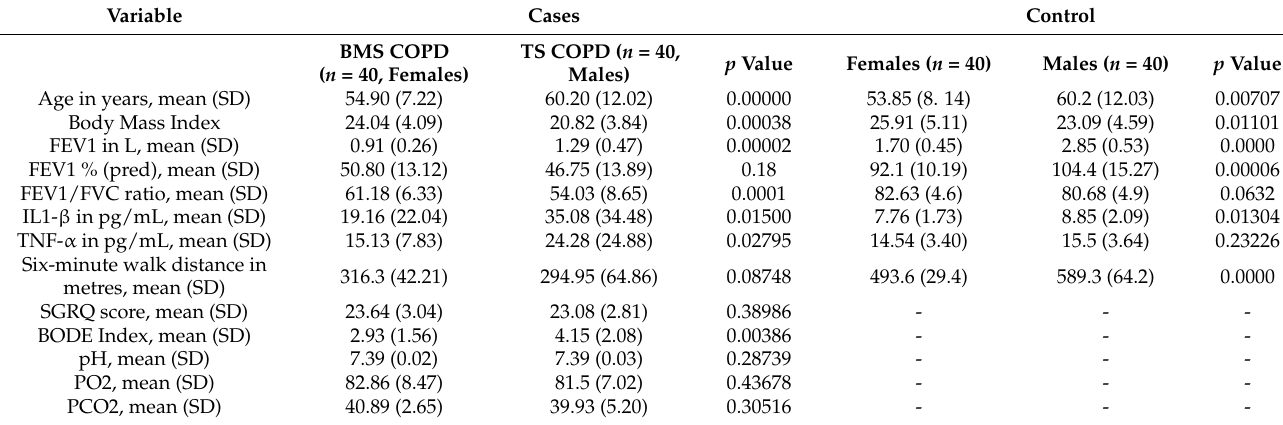
Table 2. Demographic and clinical details of sub-groups of cases and controls in the study.